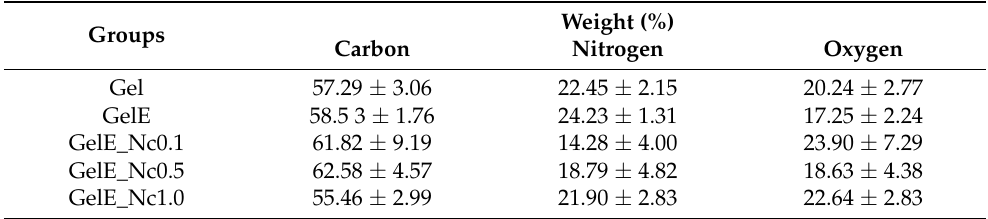
Table 1. EDX analysis showing the elemental contents of the scaffolds. All the composite scaffolds displayed similar elemental composition with the control